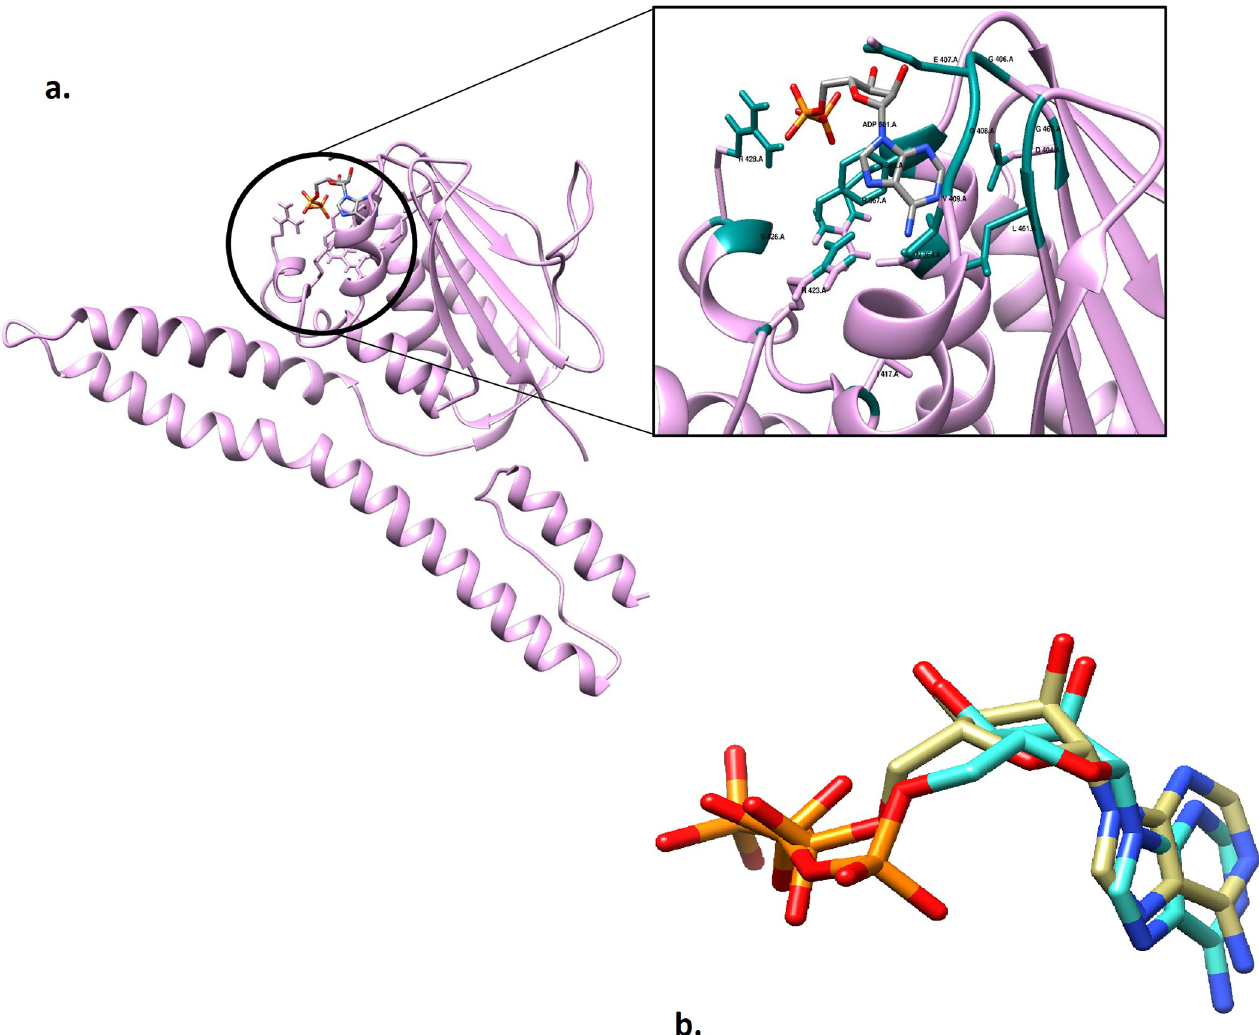
Fig 5. A. Predicted Active Site for histidine kinase: i.e. depicted by R423 (1.330 Å ), L461 (1.550 Å ), E407 (1.546 Å ), R428 (1.339 Å ) and I417 (1.548 Å ) residues. B. Pre-Docked and Post Docked Protein: the superimposed docked complex of pre docked ADP (in dark khaki) over post docked (in aqua) highlighting the accuracy of docking study in terms of RMSD indicated as 1.660 Å